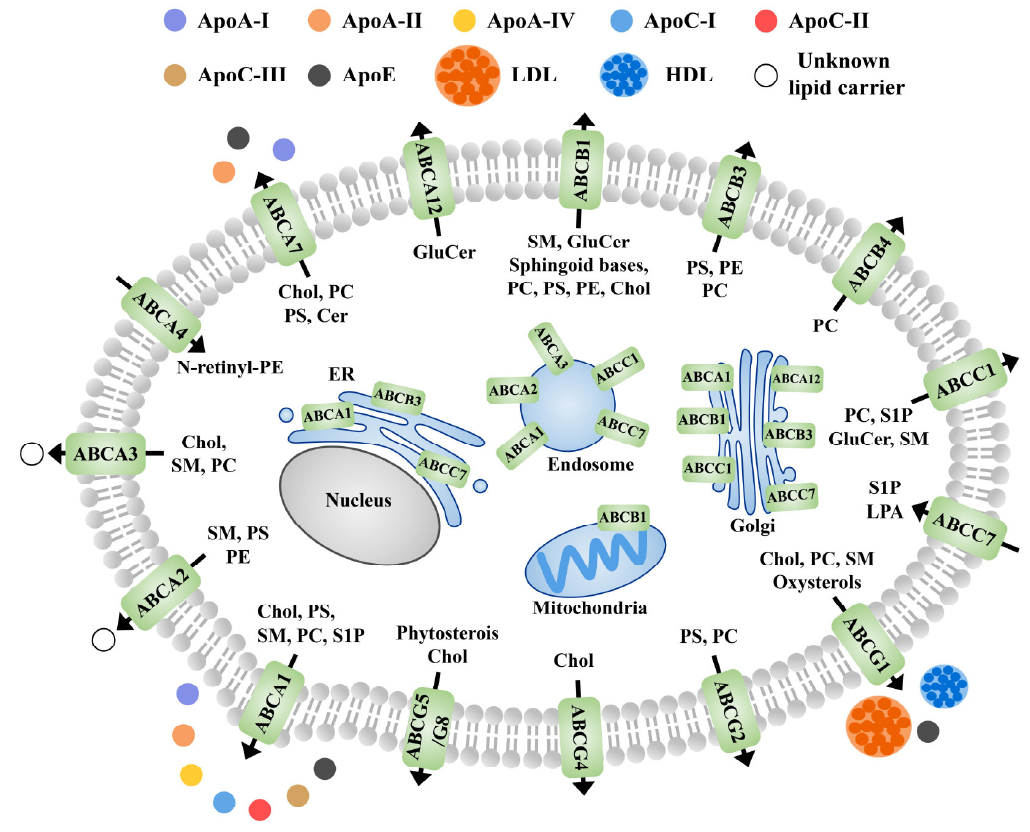
Figure 10. Schematic diagram of the subcellular localization, known receptors, and transport directions of ABC transporter proteins involved in lipid efflux in animals. Black arrows indicate the direction of transport across the plasma membrane. Apo, apolipoprotein; PS, phosphatidylserine; PC, phosphatidylcholine; PE, phosphatidylethanolamine; Chol, cholesterol; HDL, high density lipoproteins; LDL, low density lipoproteins; GluCer, glucosylceramide; Cer, ceramide; SM, sphingomyelin; N-rentinyl phosphatidylethanolamine; LPA, lysophosphatidic acid; S1P, sphingosine-1-phosphate; N-